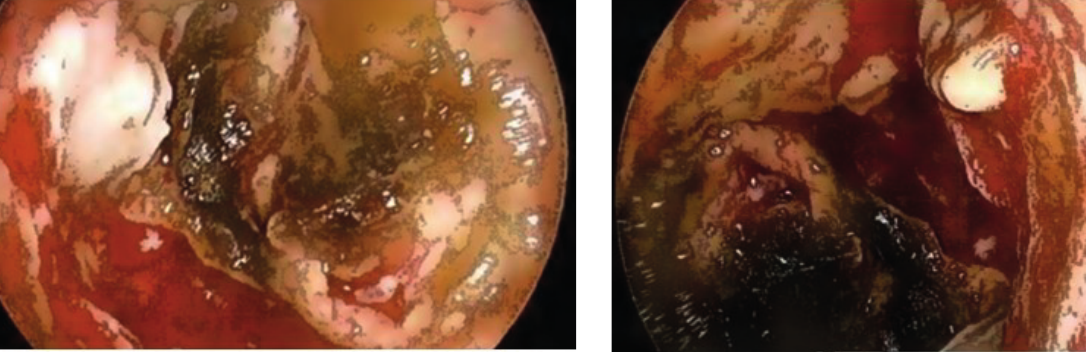
Figure 1. FNE showing extensive ulceration and necrosis of later wall, floor and septum